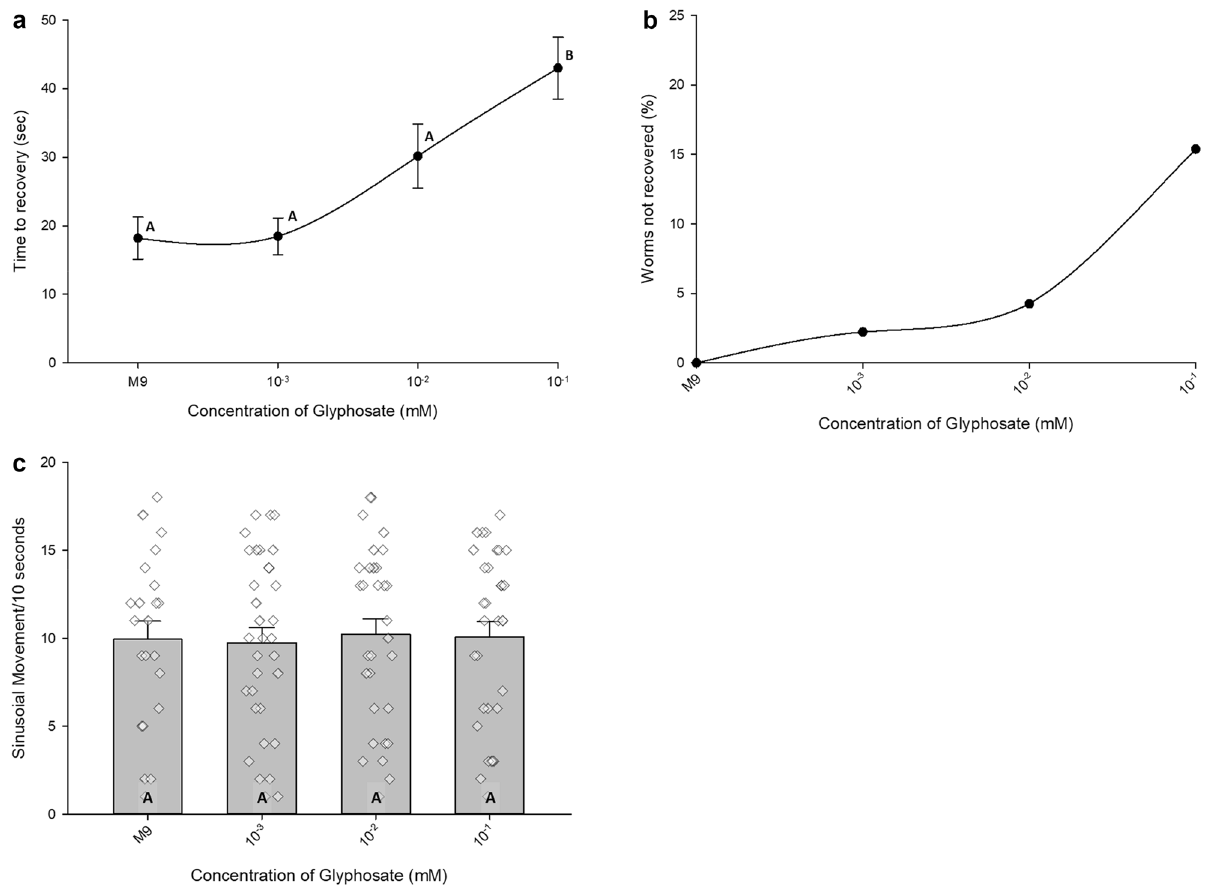
Figure 2. (a) Time to recovery for N2 nematodes exposed to logarithmic concentrations of glyphosate at 0 mM-M9 saline (n = 41), 0.001 mM (n = 45), 0.01 mM (n = 47), and 0.1 mM (n = 52). All glyphosate dilutions were done in M9 saline. Data presented as average seconds to recovery ± SEM. Statistical significance between conditions (p < .05) was designated using letters, where different letters show statistically significant differences, and the same letter indicates non-significance. P values between indicated conditions derived from Kruskal– Wallis One-Way ANOVA on ranks followed by Dunn’s Method for all pairwise multiple comparisons. ( b ) Percent of worms that did not recover from seizure when exposed to logarithmic concentrations of glyphosate at 0 mM-M9 saline (n = 41), 0.001 mM (n = 46), 0.01 mM (n = 49), and 0.1 mM (n = 60). Data presented as (number of worms not recovered in condition X/total number of worms tested in condition X) × 100. All worms recovered from seizure in M9 saline condition (0 mM glyphosate). ( c ) Number of complete sinusoidal movements per 10 s before induction of electroshock. N2 nematodes were exposed to logarithmic concentrations of glyphosate at 0 mM-M9 saline (n = 22), 0.001 mM (n = 33), 0.01 mM (n = 31), and 0.1 mM (n = 32). Data presented as mean sinusoidal movement/10 s time window ± SEM. Raw data points were overlayed on the histograms. P = 0.978, P value derived from Kruskal–Wallis One-Way ANOVA on